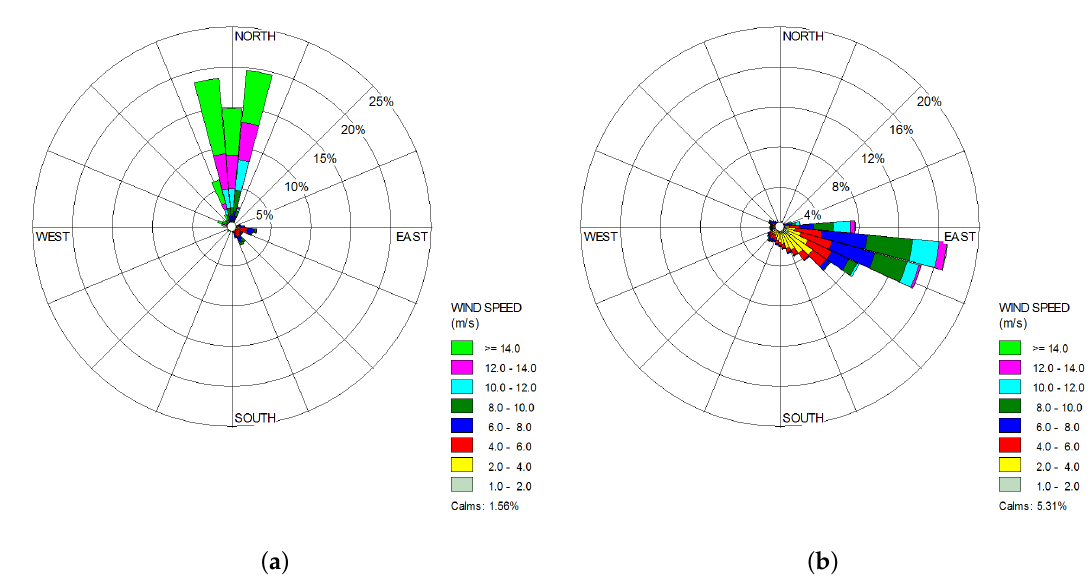
Figure 2. Wind rose of the studied sites. ( a ) La Mata, Oaxaca; ( b ) Metepec,